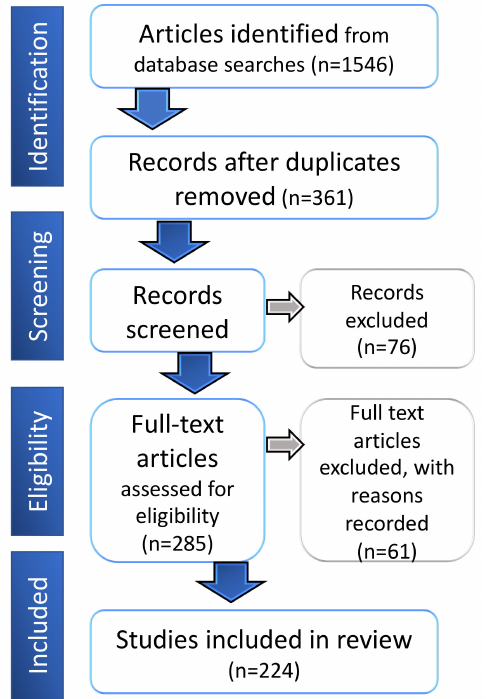
Figure 1. Flow diagram showing the process of the literature evaluation for the systematic review.